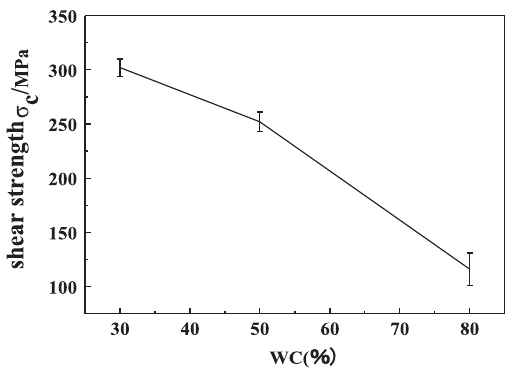
Figure 7: Fractographs of three coatings at different magnification:(a) Fractograph of 30% WC coating × 30, (b) Fractograph of 30% WC coating × 500, (c) Fractograph of 50% WC coating × 30, (d) Fractograph of 50% WC coating × 500, (e) Fractograph of 80% WC coating × 30, (f) Fractograph of 80% WC coating × 500.